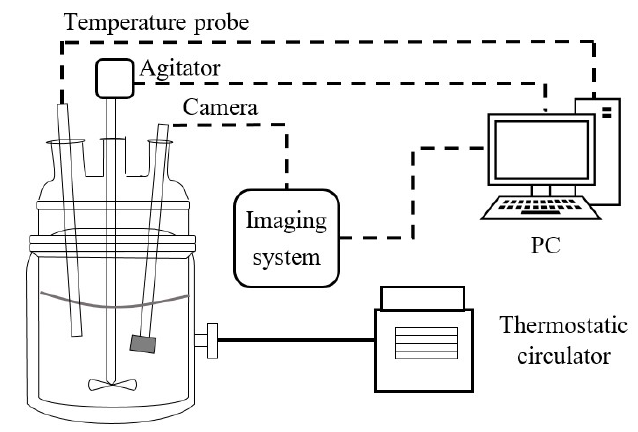
Figure 2. Schematic drawing of the experimental setup.